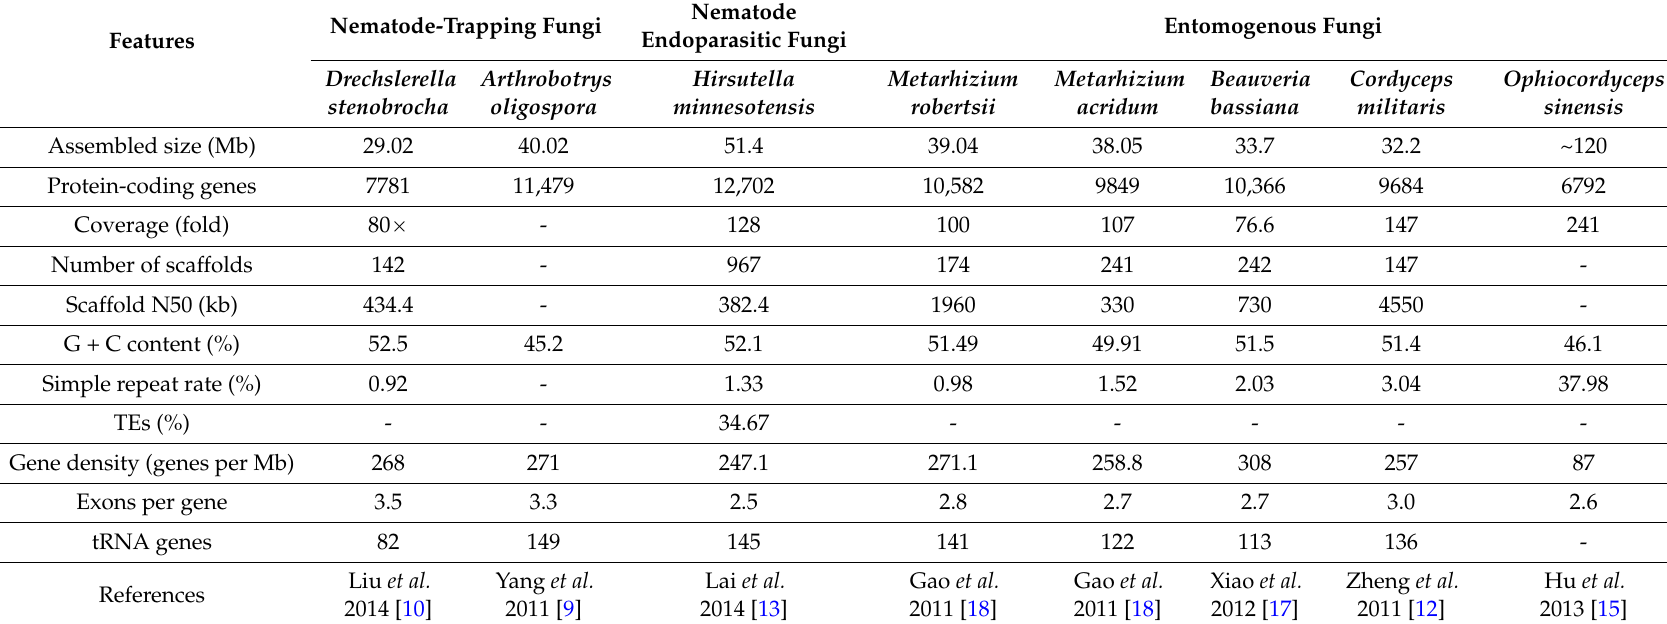
Table 1. Available genomic sequences nematophagous fungi in